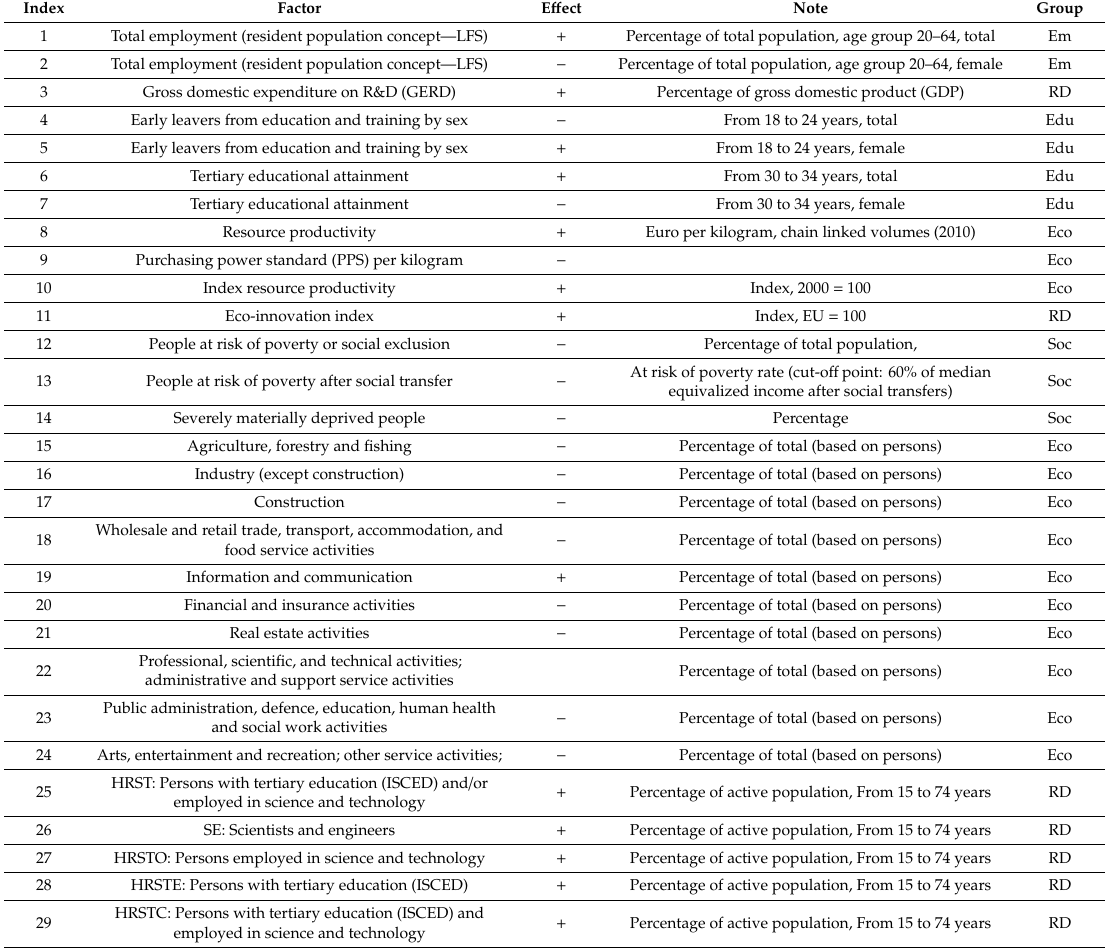
Table 3. Factors used for the